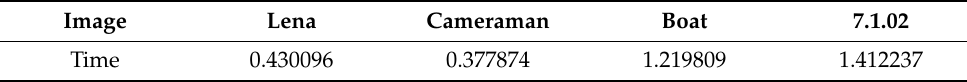
Table 1. Encryption runtime (Unit: s).